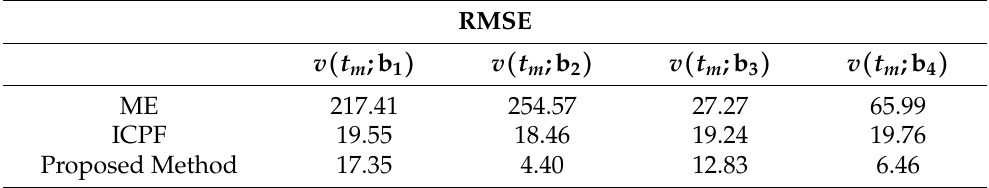
Table 4. Estimated speed RMSE of different algorithms with point simulation